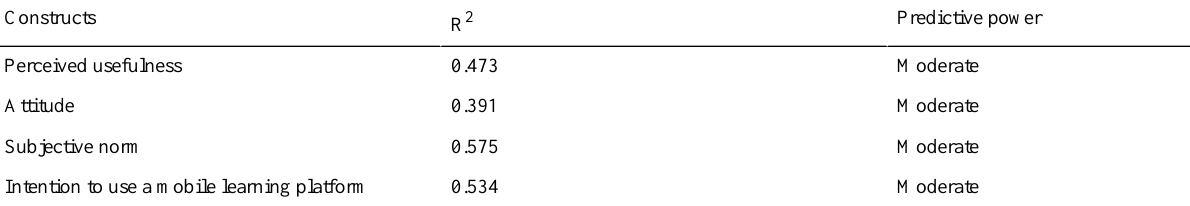
Table 7. R 2 values of the endogenous latent variables.